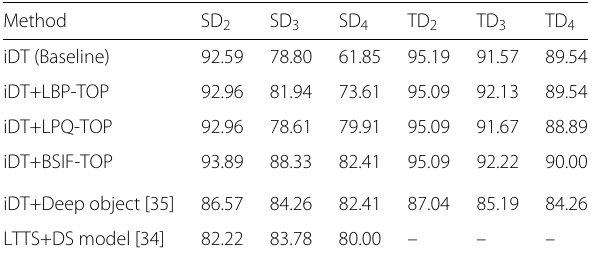
Table 2 Recognition accuracy (%) of various iDT based approaches in comparison with other approaches on downsampled versions of the KTH